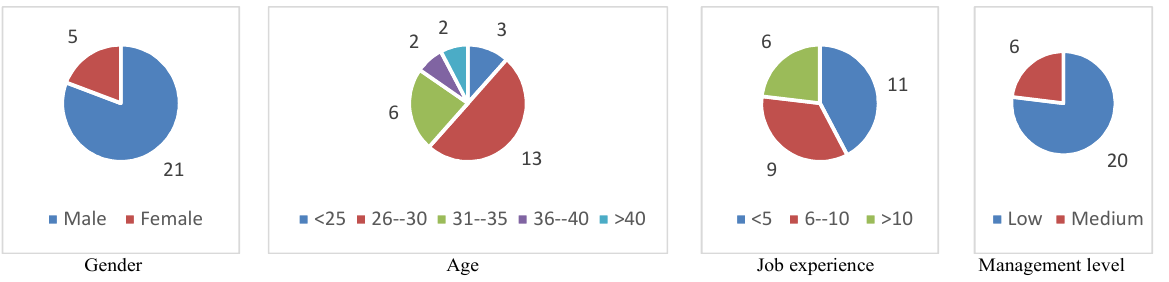
Fig. 2. Personal characteristics of the participants